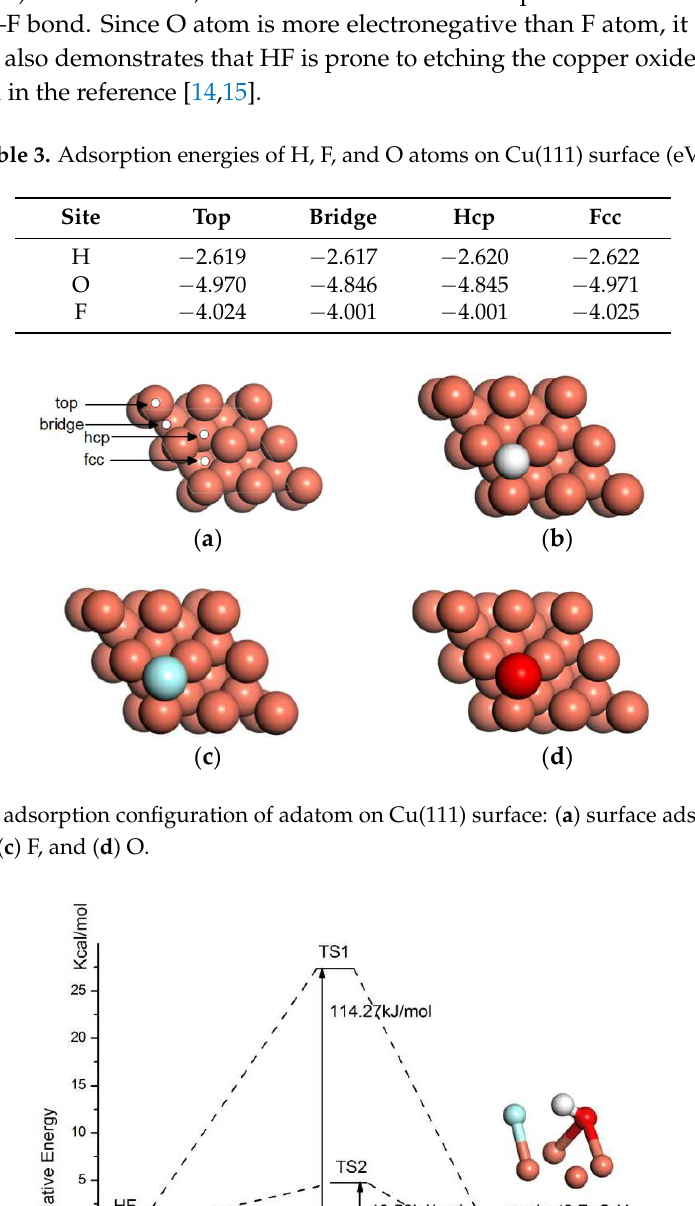
Figure 5. Schematic drawing: ( a ) the CuF 2 unit cell and ( b ) the bonds formed by the F atoms and Cu atoms in Figure 2g.